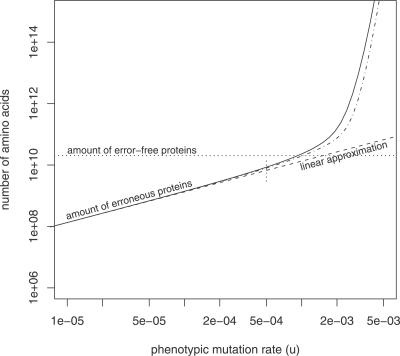
The Amount of Erroneous Proteins as a Function of the Phenotypic Mutation Rate, u
The solid curve shows the expected numberx̄ of amino acids required to synthesize abnormal proteins according to Equation 7 with values for ni and yi from yeast (see Methods and Materials). The dash-dotted curve shows the total number
of abnormal proteins. For better comparison, we scaled the number of proteins so that the dash-dotted and solid curves meet at u = 10−5. The dashed line shows the linear approximation tox̄ (see Equation 8). The dotted line indicates the amount (in amino acids) of functional proteins in a yeast cell, which equals 2.029 × 1010. Near u = 5 × 10−4 (the estimate for the global phenotypic mutation rate), the linear approximation begins to deviate noticeably from the exact value. A doubling of u at this point would result in more erroneous than error-free proteins. Another doubling would result in more than seven times as many erroneous than error-free proteins. This nonlinear increase is also observed if one considers the number of abnormal proteins (dash-dotted curve).